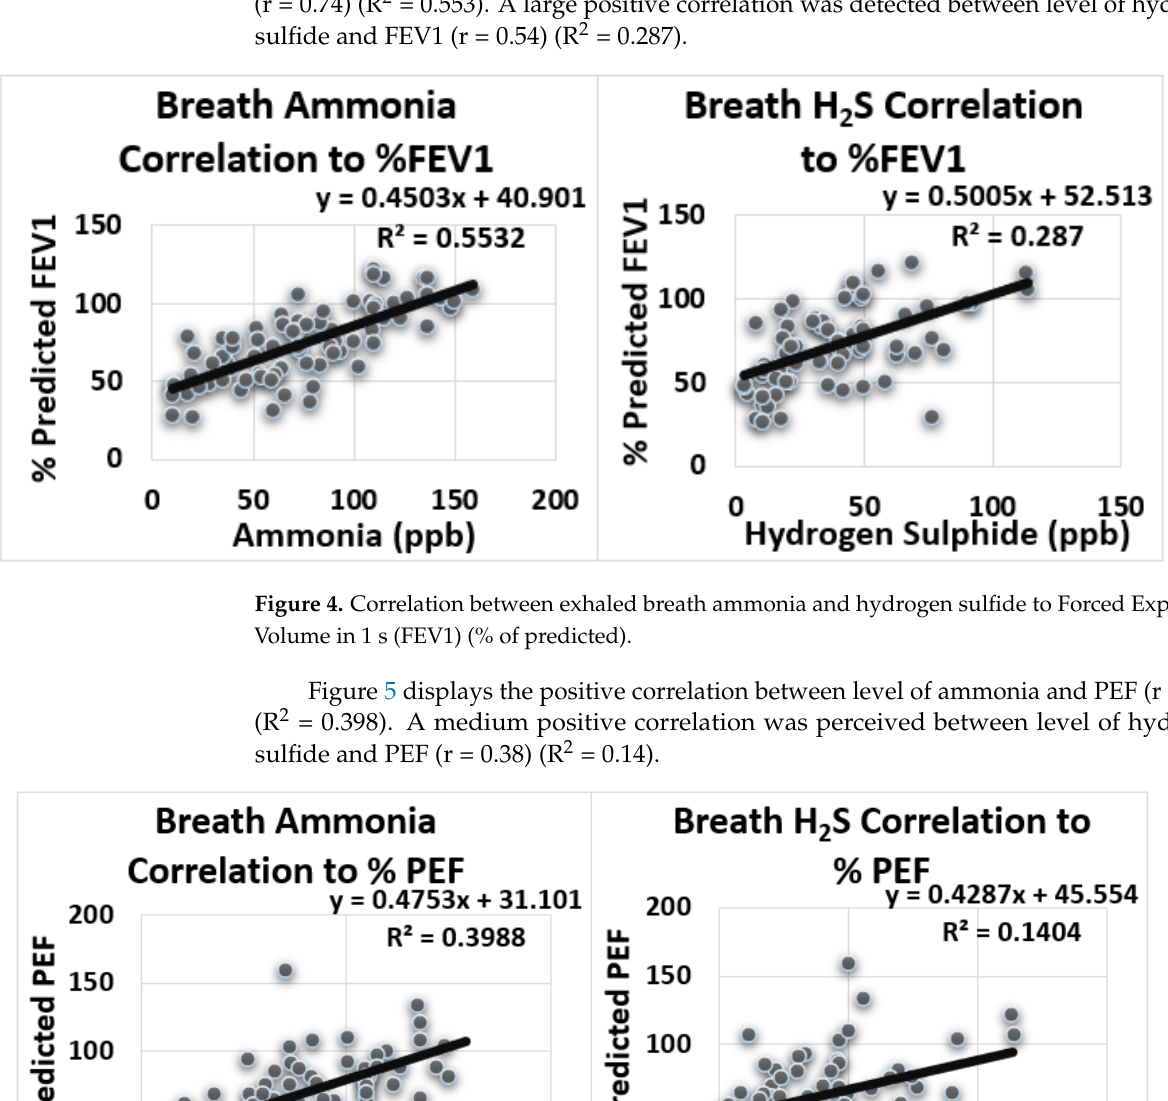
Table 3. Pearson Linear Regression Analysis of Exhaled Breath variables and Lung Function Test Variables.